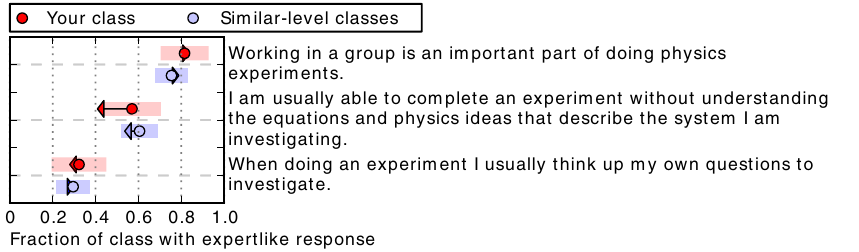
FIG. 4. Pre and post changes in students ’ personal views about “ What do YOU think when doing experiments for class? ” for your class (red) and all students in similar level classes (i.e., introductory calculus-based physics classes) (blue). The circles show the presemester survey values. The arrows indicate the pre and post changes. The shaded bars are 95% confidence intervals. The data shown are for a subset of 3 out of 30 statements.